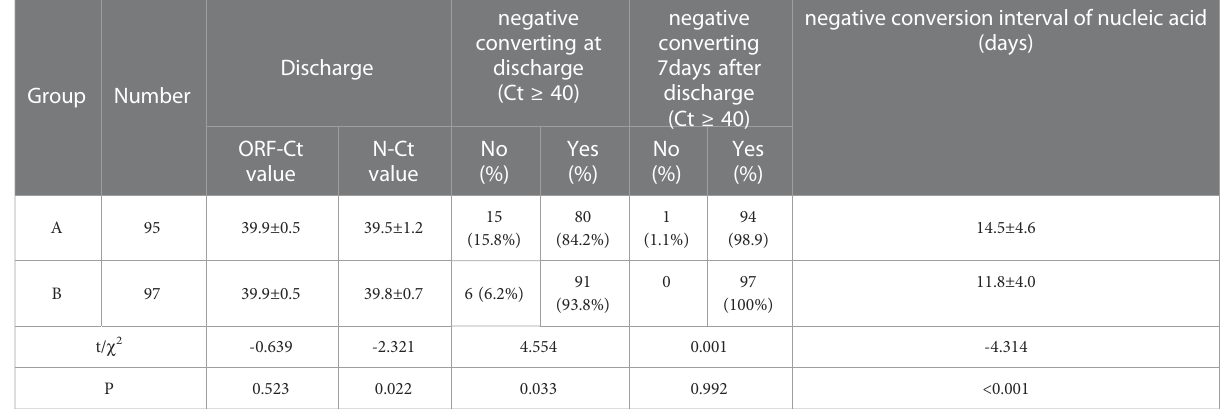
TABLE 3 Outcomes at discharge.